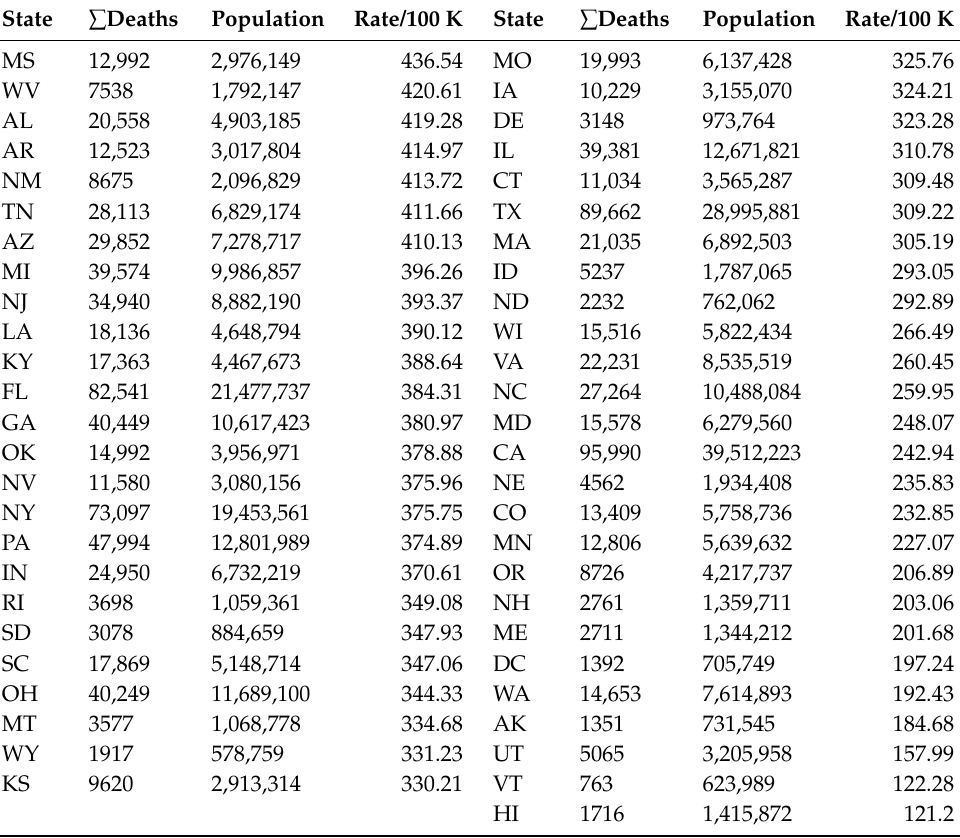
Table 2. Deaths, population, and fatality rate per 100,000 persons (sorted by fatality rate).